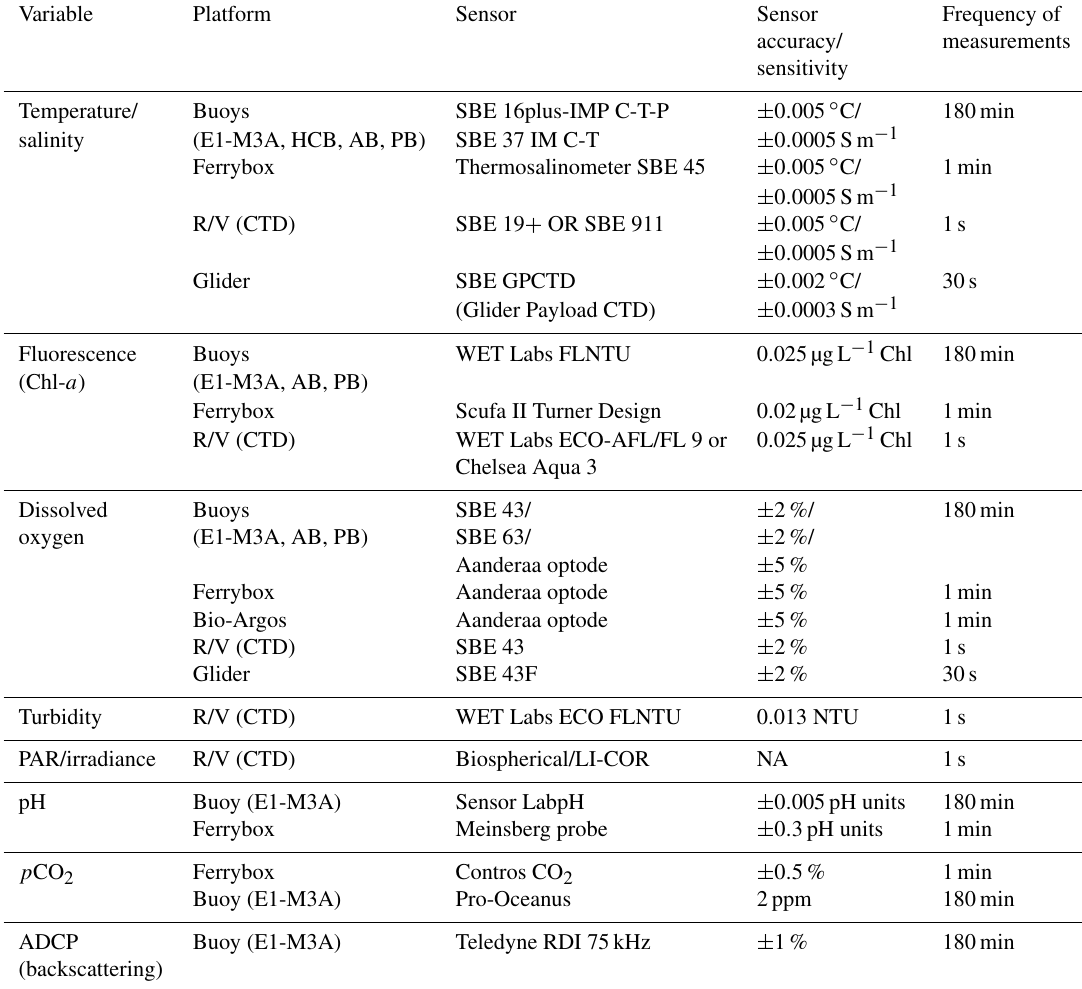
Table 1. Current status of marine BGC and associated variables ( T , S ) measured from sensors in the POSEIDON platforms. Variable Platform